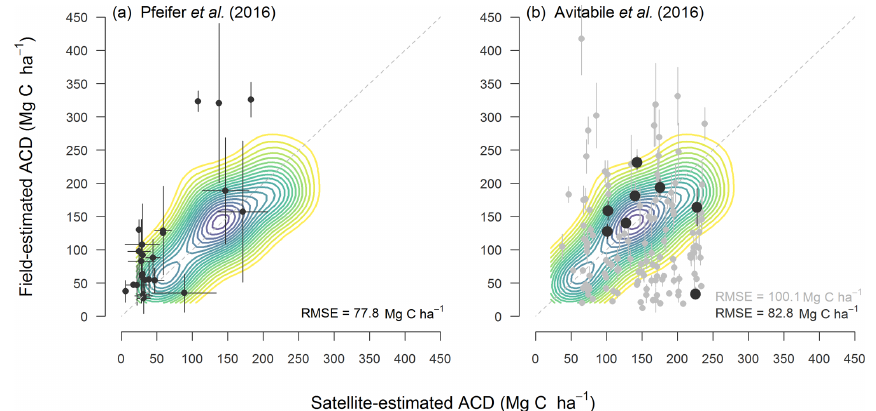
Figure 7. Comparison between field-estimated aboveground carbon density (ACD) and satellite-derived estimates of ACD reported in (a) Pfeifer et al. (2016) and (b) Avitabile et al. (2016). In panel (b) large black points correspond to grid cells in Avitabile et al.’s (2016) pantropical biomass map for which at least five plots covering a cumulative area ≥ 1ha were sampled in the field. By contrast, grid cells for which comparisons are based on less than five plots are depicted by small grey circles. Error bars correspond to standard deviations, while the RMSE of the satellite estimates is printed in the bottom right-hand corner of the panels (note that for panel b the RMSE in grey is that calculated across all plots, whereas that in black is based only on the subset of grid cells for which at least five plots covering a cumulative area ≥ 1ha were sampled in the field). For comparison with ACD estimates obtained from airborne laser scanning, a kernel density plot fit to the points in Fig. 2d is displayed in the